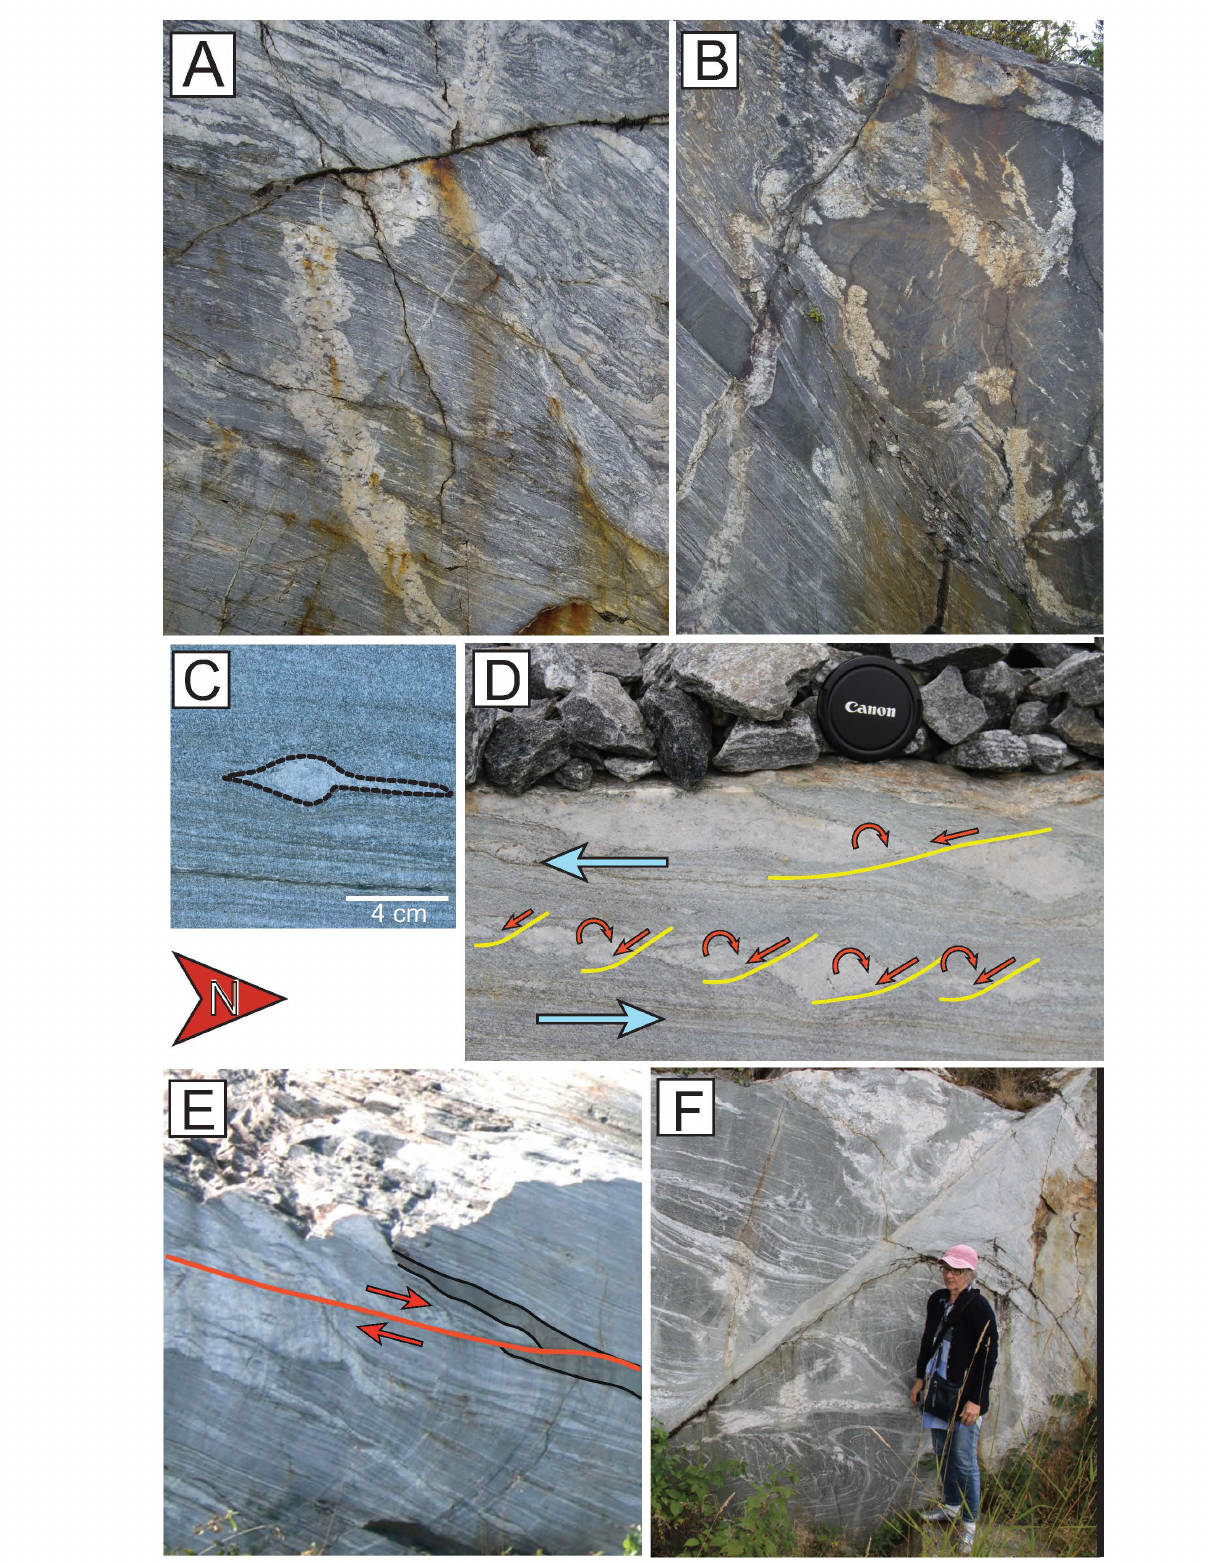
Figure 7. (A, B) Examples of the transition from regular mylonite gneiss, cut by straight or only slightly deformed pegmatite, to complex superimposed deformation in the shadow zones of large amphibolite boudins, also strongly affecting the pegmatites. (C) Example of mantled winged porphyroclast. (D) Shear bands transecting the foliation in the biotite gneiss and rotation of the clasts. Indicating a top to the south movement. (E) Normal fault with top to north movement, displacing a garnet-amphibolite vein by 16 cm. (F) Late cataclastic fault (site C1 in Fig. 3). N-arrow applies to all the